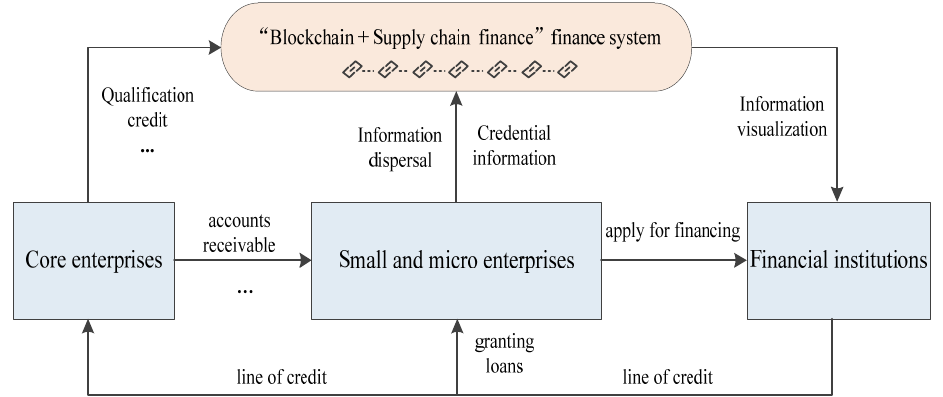
Figure 1. The flow chart of supply chain financing using BT.